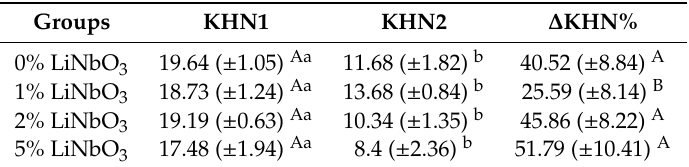
Table 3. The results of the initial Knoop hardness (KHN1), final Knoop hardness (KHN2), and softening in solvent ( ∆ KHN%) of the experimental adhesives expressed in the mean and standard deviation for each group.